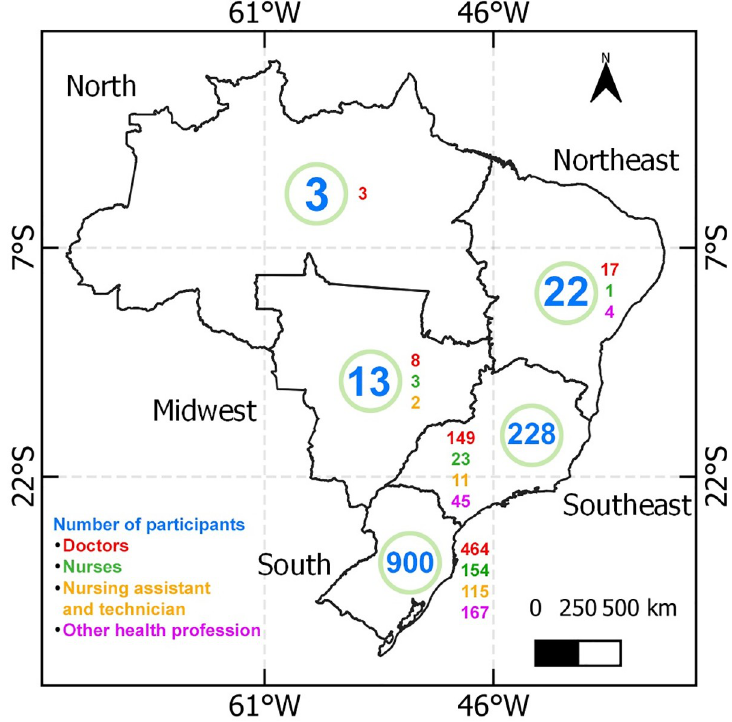
Fig 1. Number of participants, type of profession, and their distribution in each region of